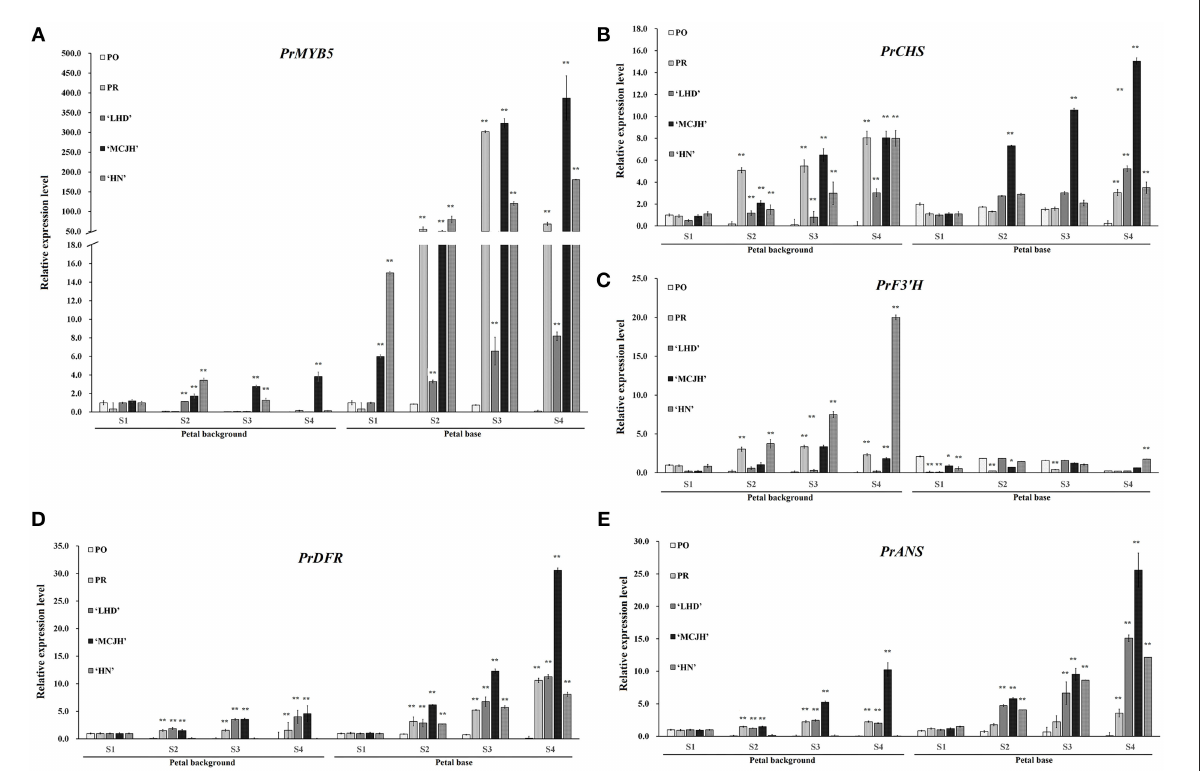
FIGURE4 The expression profiles of PrMYB5 and four related structural genes in P. rockii (PR), P. ostii (PO), and three tree peony cultivars “Lanhudie” (LHD), “Mochi Jinhui” (MCJH) and “High Noon” (HN) using qRT-PCR. The expression profiles of PrMYB5 (A) , PrCHS (B) , PrF3’H (C) , PrDFR (D) , and PrANS (E) in all samples. S1–S4 represent four different blooming